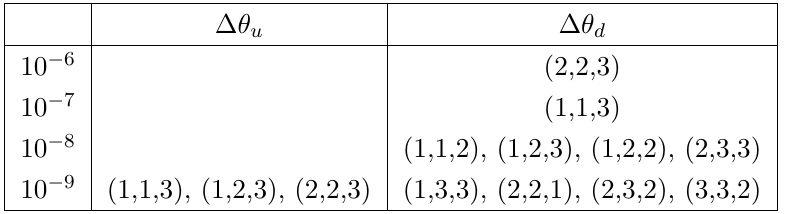
Table 8 . Maximal possible corrections to the strong CP phase from ( i; j; k ) terms in eq. (D.11). With hierarchical M a , the correction is much